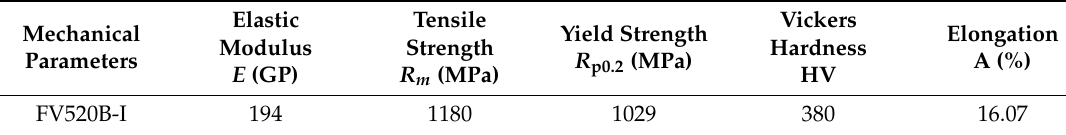
Table 2. Mechanical property of FV520B-I.